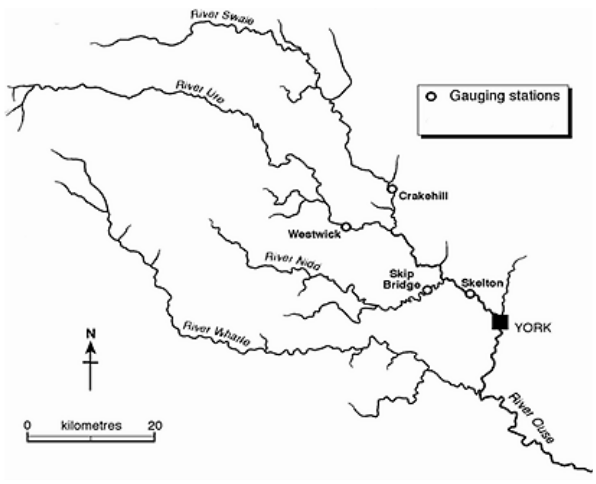
Fig. 5. River Ouse catchment in North Yorkshire, UK. Figure 5. River Ouse catchment in North Yorkshire, UK